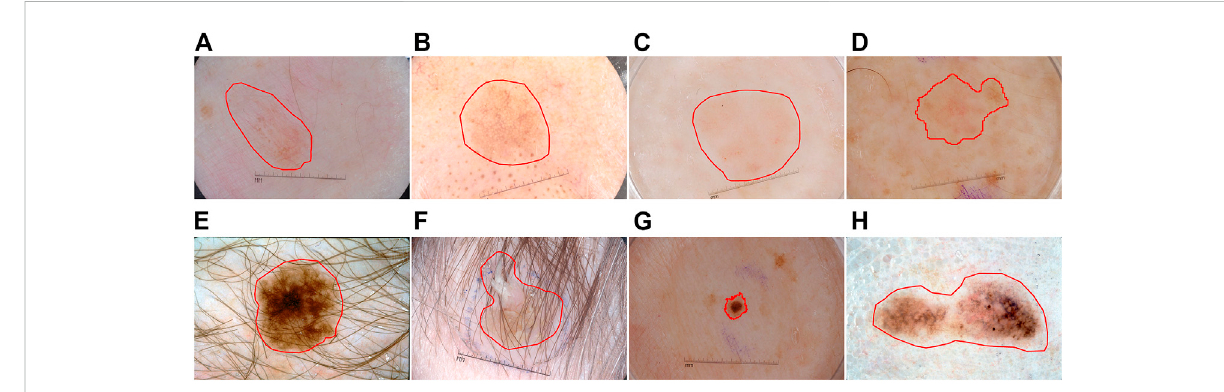
FIGURE 1 Typical skin lesion segmentation images: (A – D) the contrast between the lesion and the surrounding skin is low, (E – F) occlusion by hair and bubbles, (G – H) characterized by